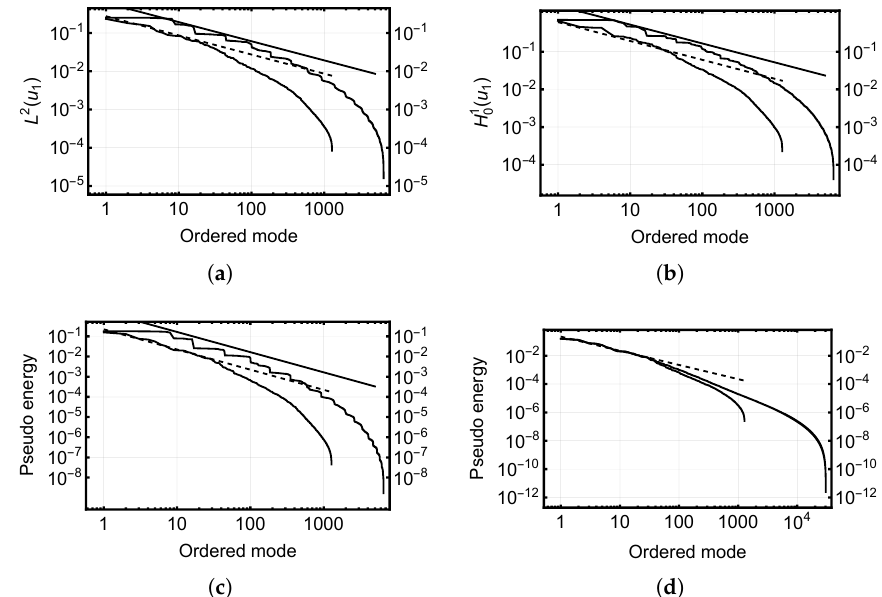
Figure 13. Convergence comparison between the two configurations: Computed quantity of interest (sorted in magnitude) vs. the basis polynomials. For both norms, the rate is = 1/2, and for the pseudoenergy = 1. The solid straight line is the estimated upper bound for Case 2, and the dashed one for Case 1. Notice that the number of poorly performing bases is a small fraction of the total in both cases. In ( d ), both solid curves represent Case 1, with the longer one corresponding to the total ( u ) , ( c ) (cid:107) u (cid:107) (cid:107) u (cid:107) degree selection. ( a ) L 2 ( u 1 ) , ( b ) H 1 A 0 , ( d ) A 0 . 1 0